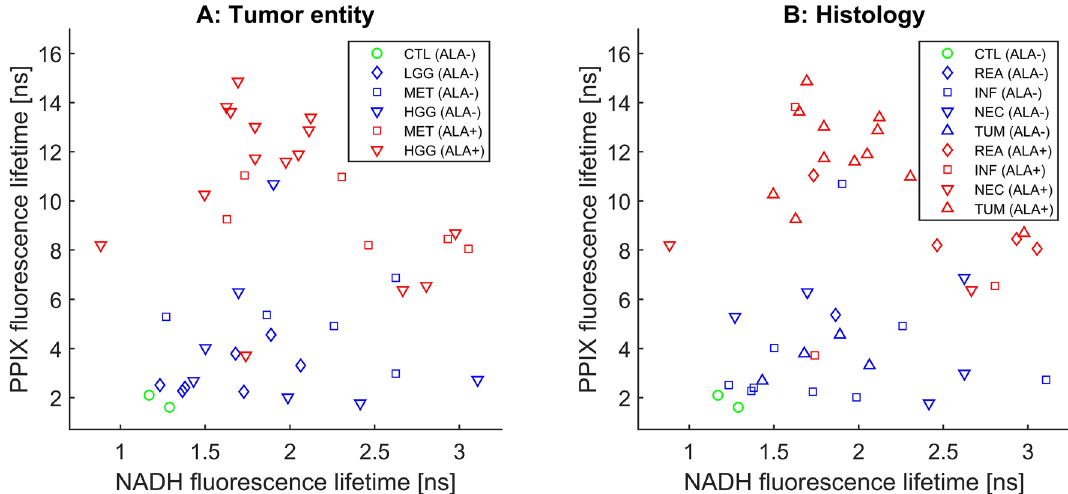
Figure 2. Overview of the NADH and PPIX fluorescence lifetime for each sample depending on tumor entity and tissue type—Here we show the median NADH and PPIX fluorescence lifetime for each sample. Non- pathological samples are shown in green. Samples with no visible 5-ALA fluorescence during surgery (ALA−) are shown in blue while tissue exhibiting fluorescence visible to the surgeon (ALA+) is marked in red. The symbols either define the tumor entity ( a ) or the tissue histology ( b ). Especially high grade gliomas with visible fluorescence during surgery show a rather compact cluster. Note that necrotic tissue had reduced PPIX lifetime combined with a wide range of NADH lifetimes. The sample with most necrosis showed NADH lifetimes below 1 ns suggesting glycolytic energy metabolism.